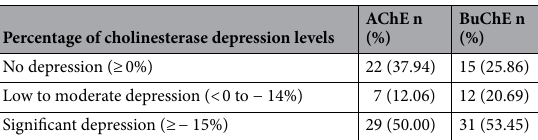
Table 4. Percentage of AChE and BuChE depression